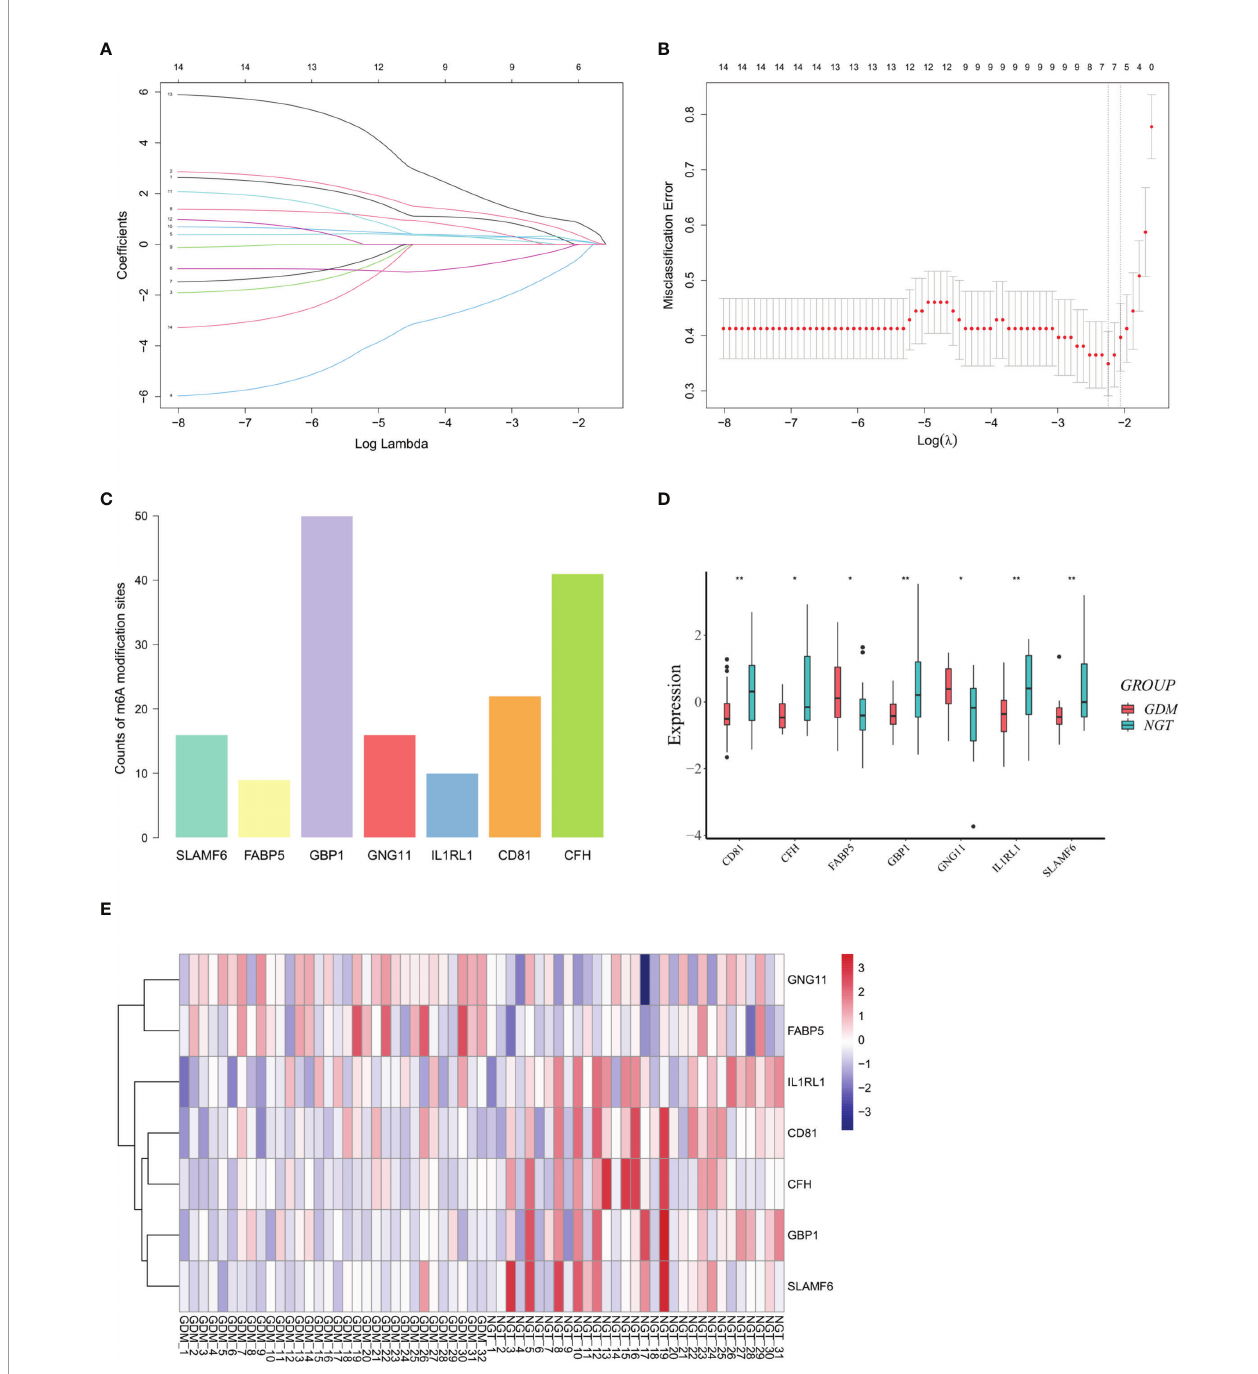
FIGURE 5 | Differentially expressed m 6 A-related genes (DMRGs) signature selection through LASSO regression analysis. (A) LASSO coef fi cient pro fi les of 14 differentially expressed m 6 A-related genes (DMRGs). The coef fi cient pro fi le plot was produced against the log (lambda). (B) The partial likelihood deviance (binomial deviance) curve was plotted versus log (lambda) to verify the optimal lambda value. Dotted vertical lines were drawn based on the 1-SE criteria. Seven DMRGs with non-zero coef fi cients were selected by optimal lambda. (C) Counts of potential m 6 A modi fi cation sites of the selected DMRGs. (D) Relative expression levels of CD81, CFH, FABP5, GBP1, GNG11, IL1RL1 , and SLAMF6 . (E) Hierarchical clustering of the expression pattern of CD81, CFH, FABP5, GBP1, GNG11, IL1RL1 , and SLAMF6 . Asterisks denote statistical signi fi cance ( *p < 0.05; **p <